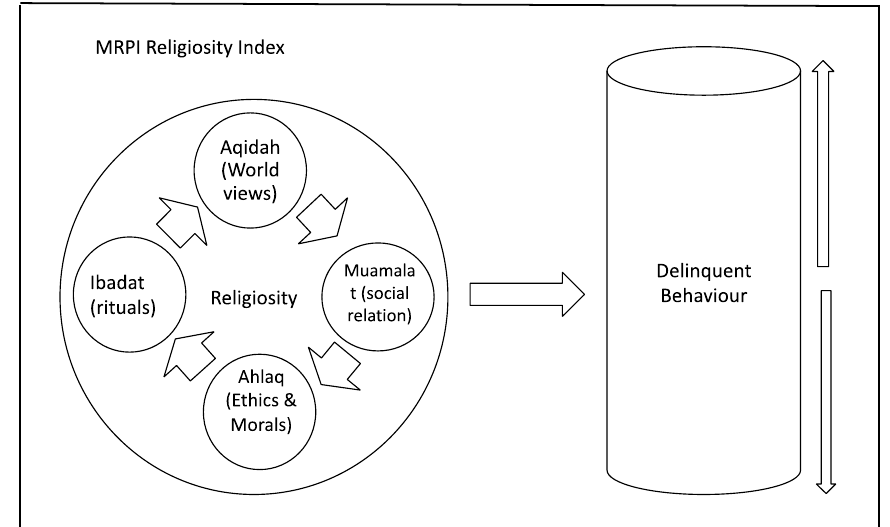
Figure 1. The association between Islamic religiosity and delinquent